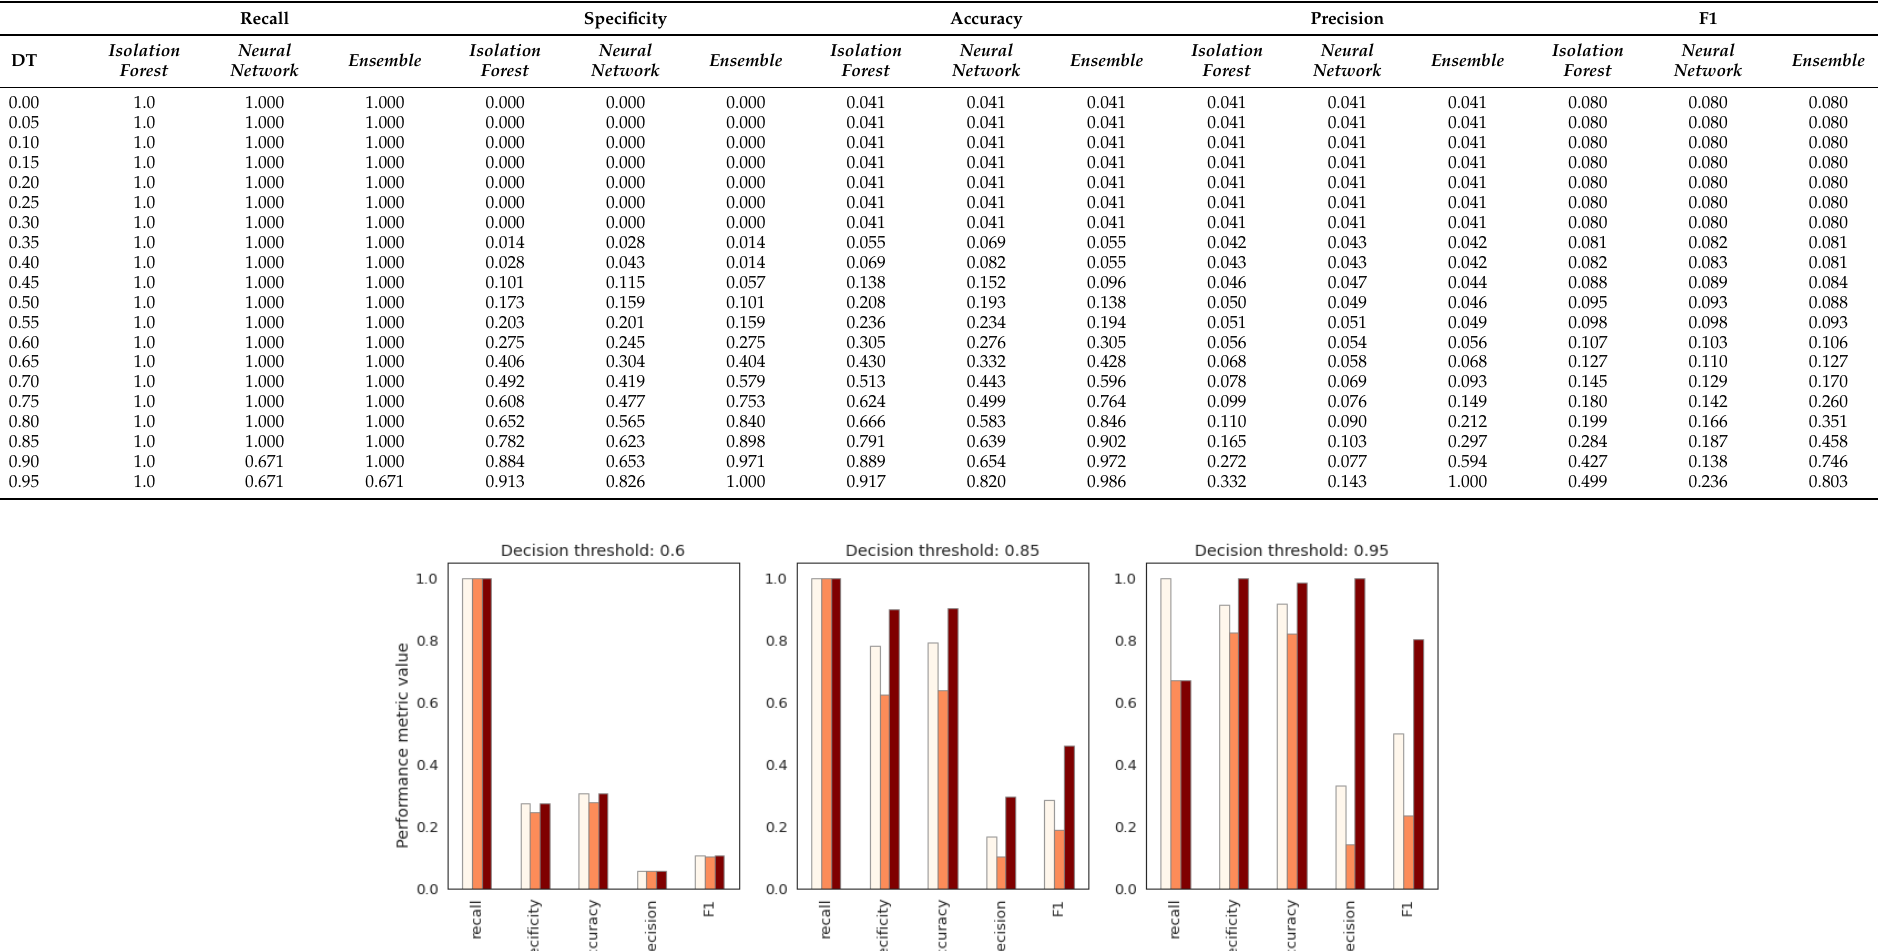
Table 7. Metrics comparison among the single and ensemble methods with respect to the decision threshold (DT).